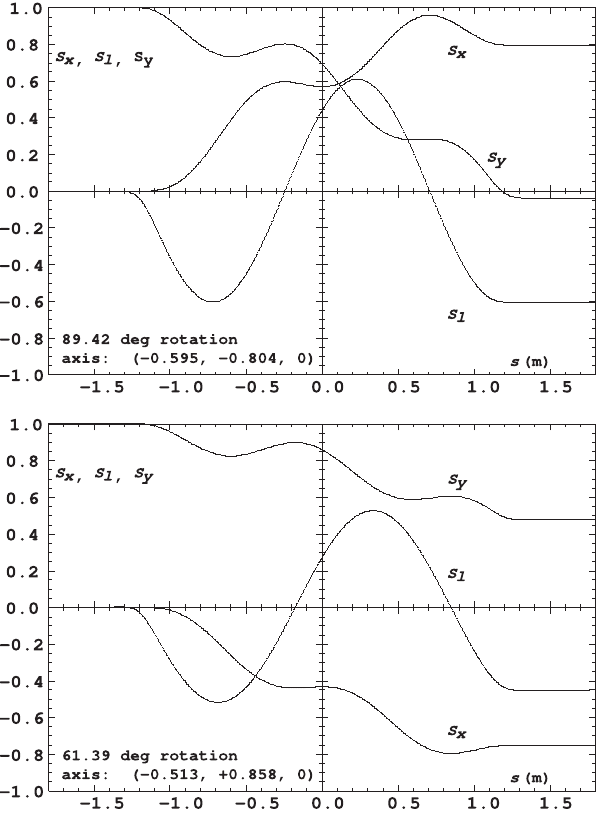
FIG. 26. Rotation of an initially vertical spin, along the closed orbit across a 360°-twist rotator helix. Top: L þ left-handed helix. Bottom: R þ right-handed helix.